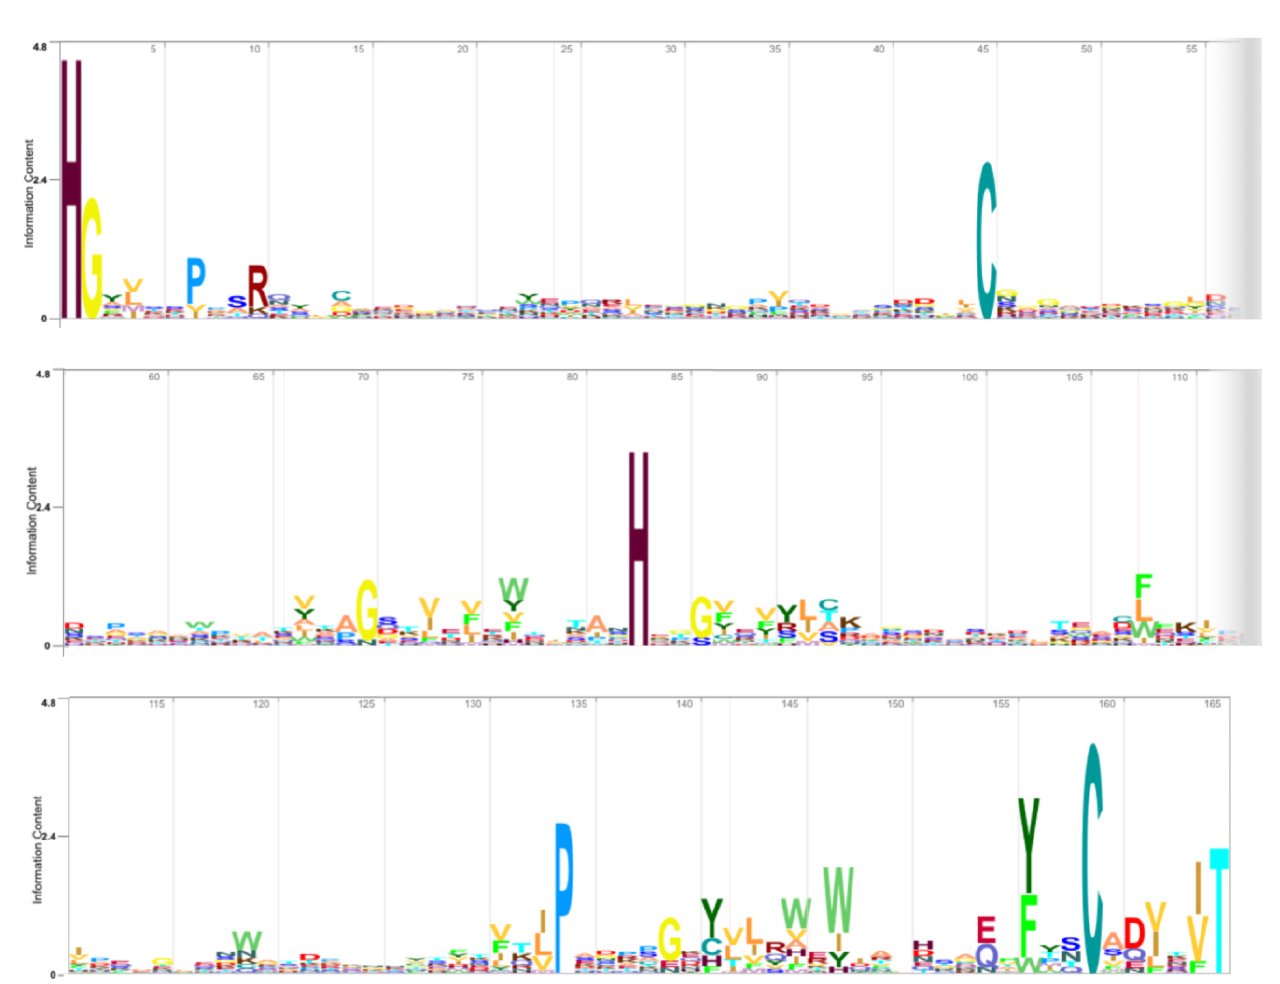
Figure 2. Logo of the core LPMO pHMM after 10 search iterations of the UniProt database (created using the HMMER web server). The height of the letter indicates the information content (level of conservation and the number indicates the position in the